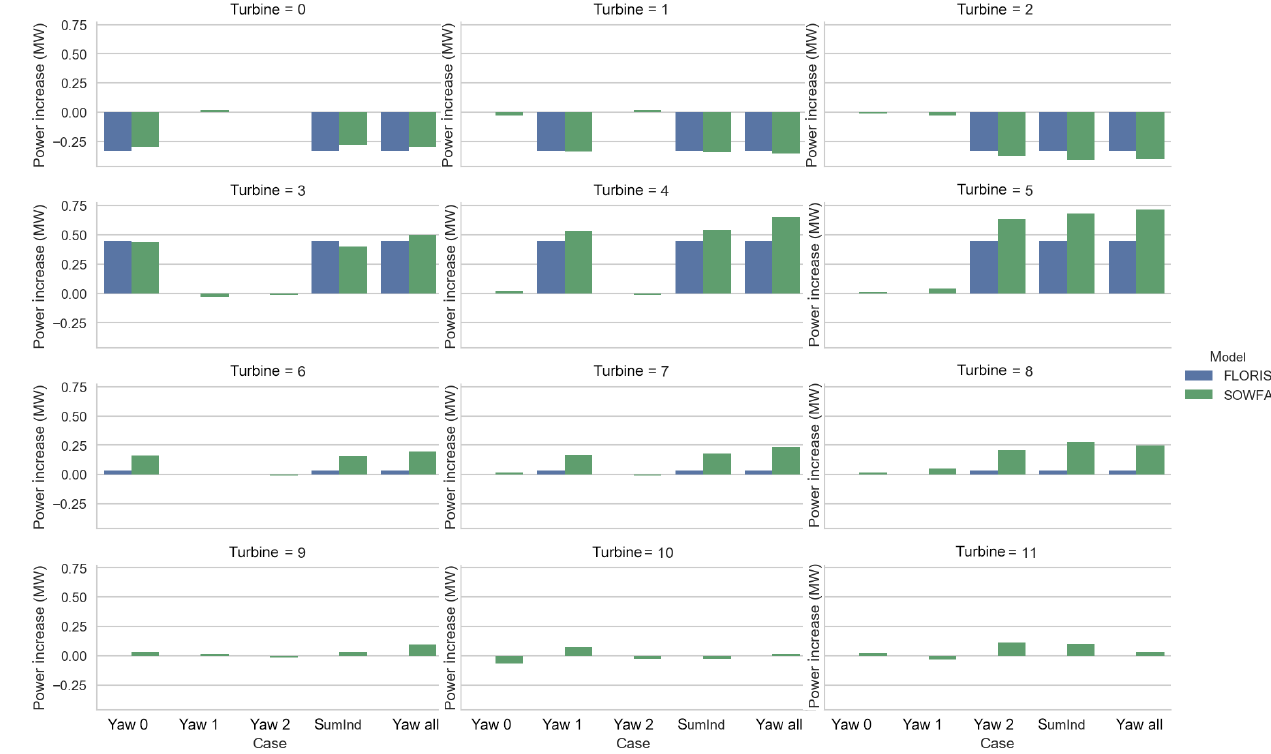
Figure 11. Change in turbine power relative to baseline for each turbine across the various scenarios in both SOWFA and FLORIS.